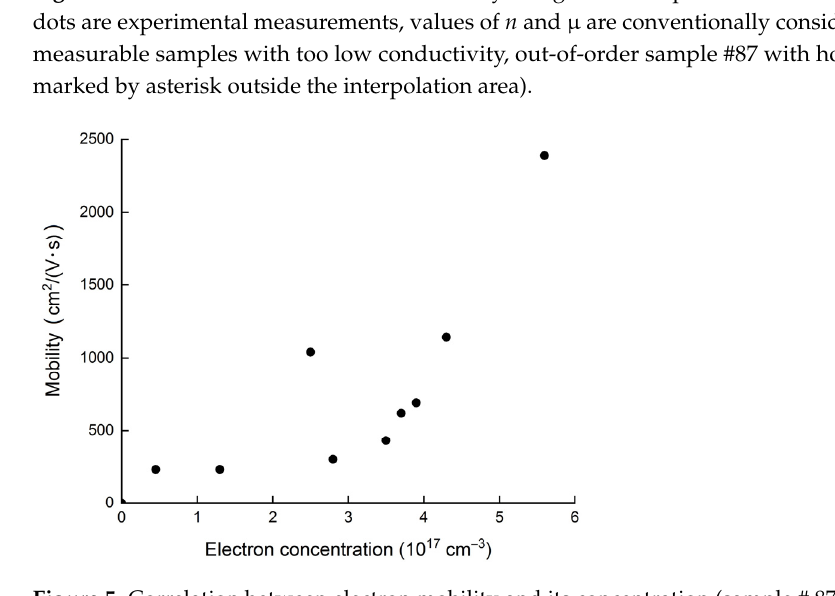
Figure 5. Correlation between electron mobility and its concentration (sample # 87 with hole conductivity is excluded).